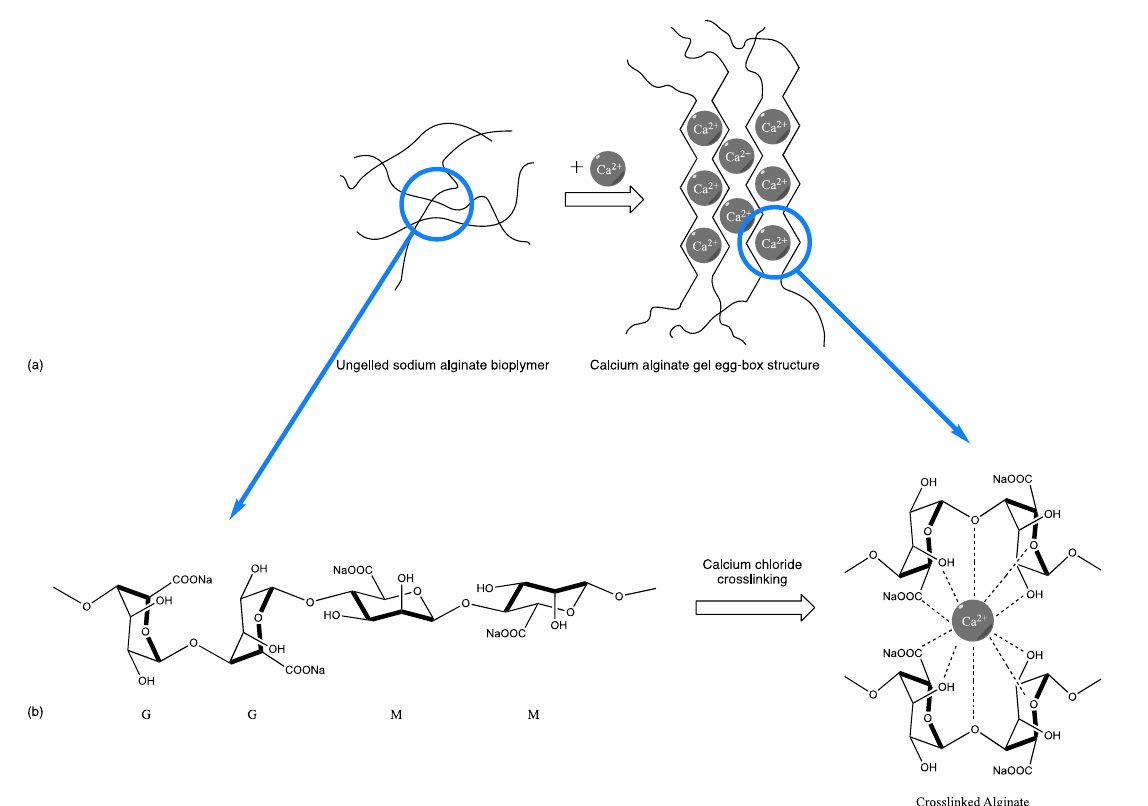
Figure 2. Alginates polycations crosslinking, ( a ) molecular overview, ( b ) organization at atomic level. [Adapted with permission from Ref. [20]. 2022, Elsevier]